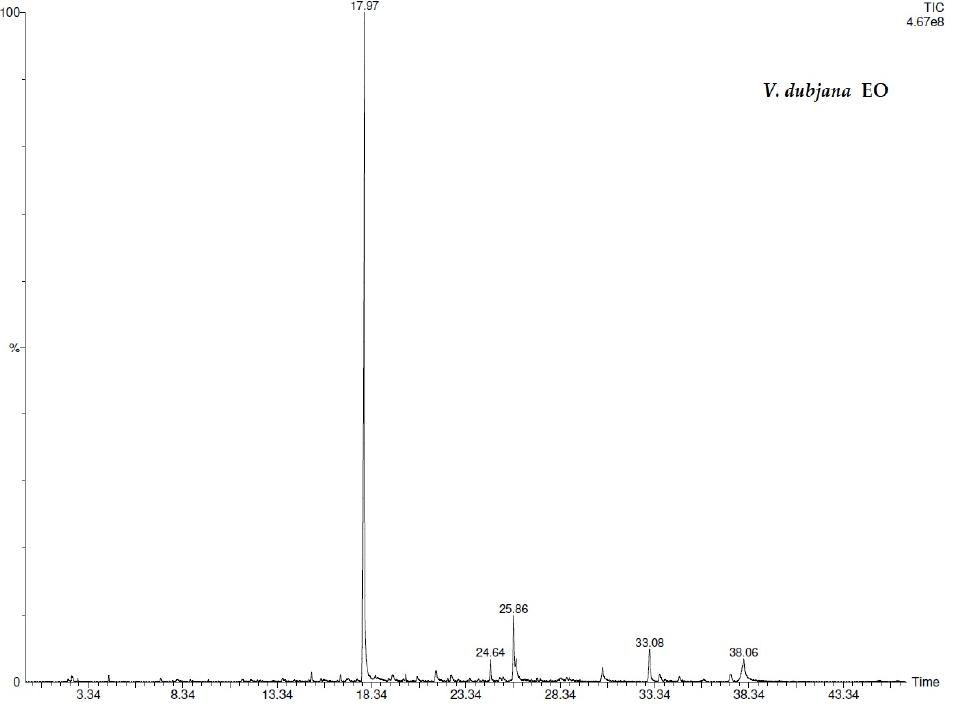
Figure 3. GC/GC-FID chromatograms of V. dubjana EO.